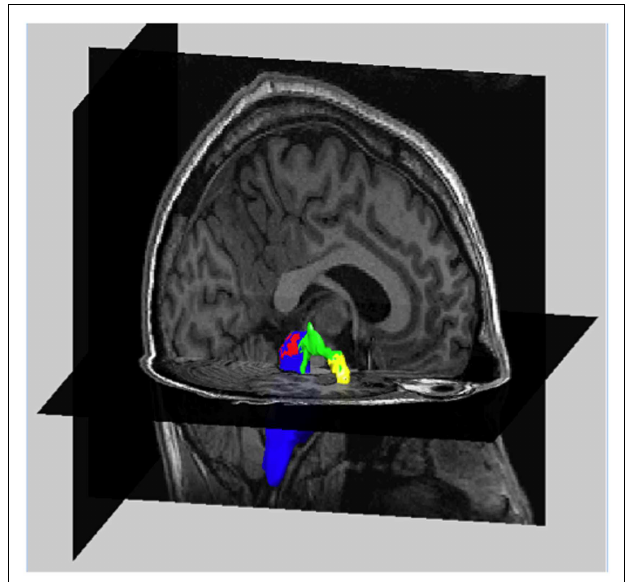
FIGURE 1 | Example of tractography results in one subject. The magnetic resonance image (MRI) of one subject is shown. (Cutaway views of a sagittal and axial slice). Overlaid on the MRI are volume renderings of the midbrain (blue) containing the raphe nuclei (red), the right amygdala (yellow), and the tracts between these regions (green). At each voxel, the number of tracts between midbrain and right amygdala were determined and used as weighting factors in the calculation of average fractional anisotropy. Only voxels containing more than 40 tracts are